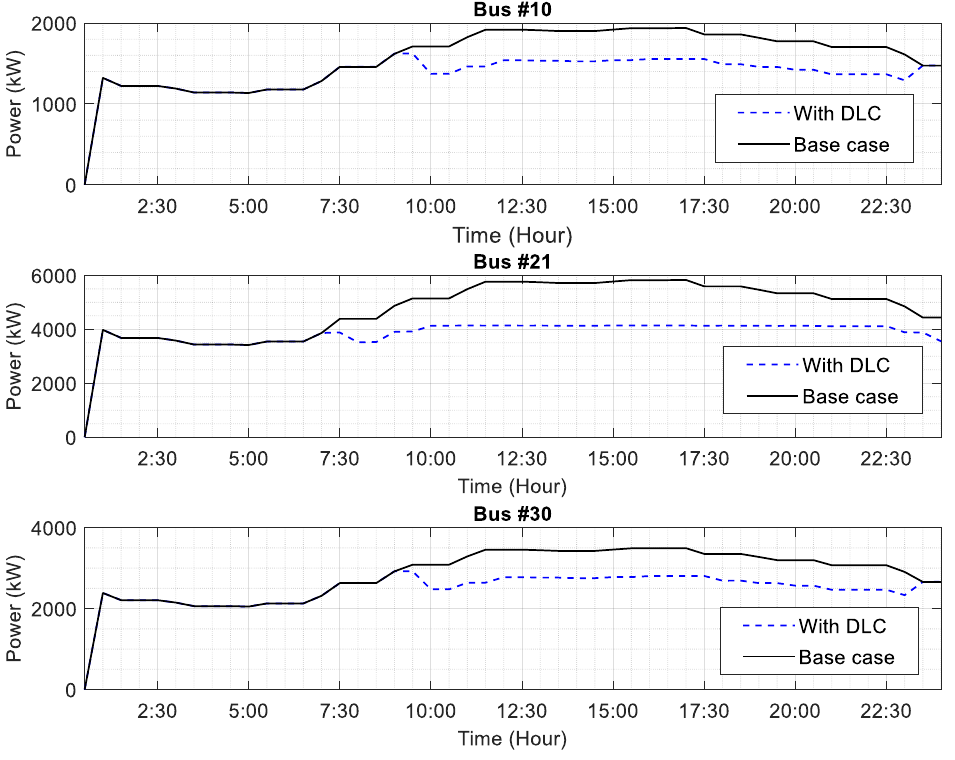
Figure 10. Case IV: Real power vs. time with / without DLC. Table 4. Case IV: Active power with / without